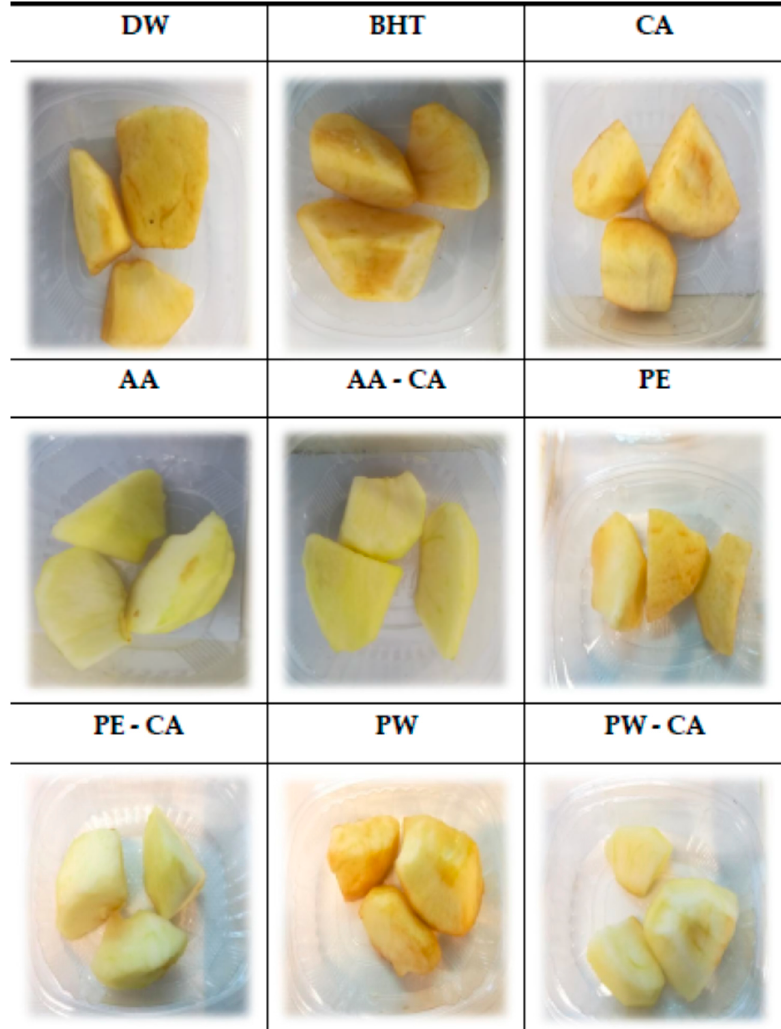
Figure 1. Changes of browning index (BI) expressed as values of Δ Browning Index ( Δ BI) of fresh-cut apples treated with different preservative media (Table 1) Data are referred to storage at 20 ± 1 °C ( t = 2 and 4 h) and 4 ± 1 °C ( t = 1 and 3 days). Values are means ± SE and different letters indicate significant statistical difference ( p ≤ 0.05).